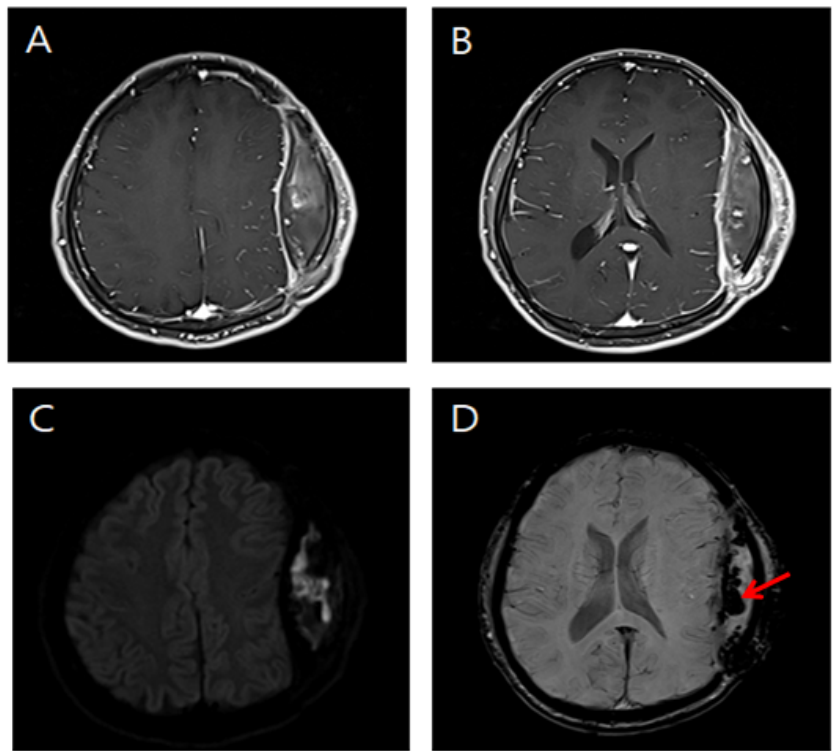
Figure 4. Brain magnetic resonance images of the patient. ( A , B ) Post-contrast T1-weighted images show rim enhancement of the fluid collection. ( C ) Diffusion-weighted image of the epidural fluid collection demonstrates restricted diffusion. ( D ) Susceptibility-weighted image of the epidural fluid collection reveals multiple punctate hypointensities secondary to hemorrhage (arrow). Brain magnetic resonance imaging showed a mass effect caused by a hemorrhagic component and epidural abscess (Figure 4).